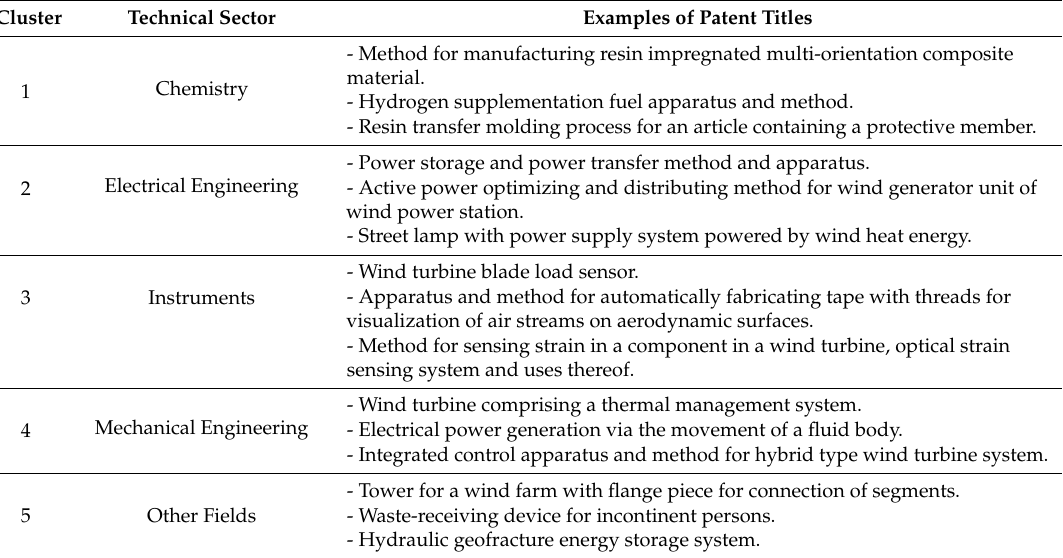
Table 5. Examples of patent titles from the technical